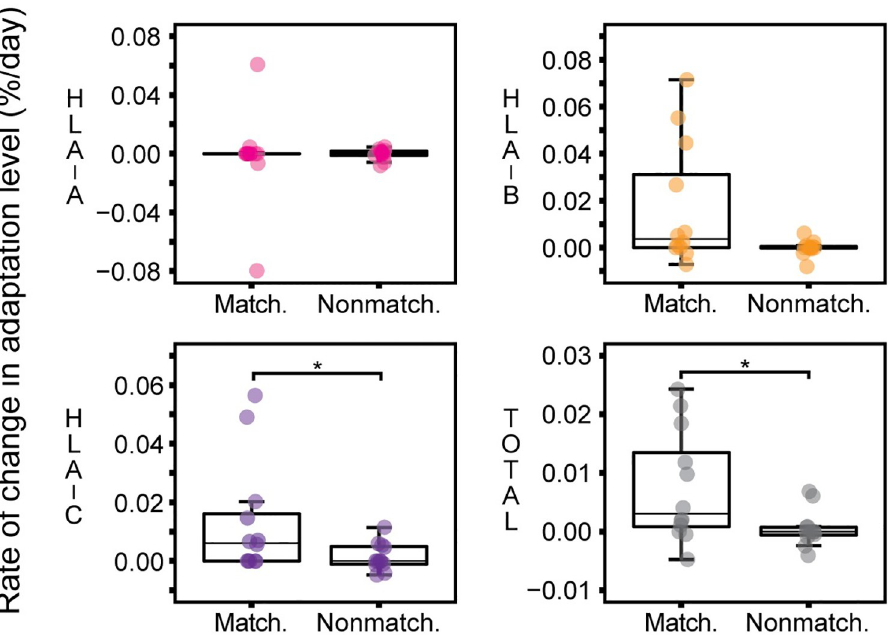
Fig 4. Accumulation of HLA–C-associated HLA-matched adaptations is suggestive of strong HLA–C-associated CTL immune pressure. HLA-C exhibits the greatest difference between HLA-matched and HLA-nonmatched adaptation rate ( � , p = 0.029), and appears to greatly contribute to the difference in total HLA-matched and HLA- nonmatched adaptation rate ( � , p = 0.037). The HLA-matched and HLA-nonmatched rate of change does not differ significantly for HLA-A ( p = 0.689), however a trend was identified for HLA-B ( p = 0.068). Analyses using paired Wilcoxon